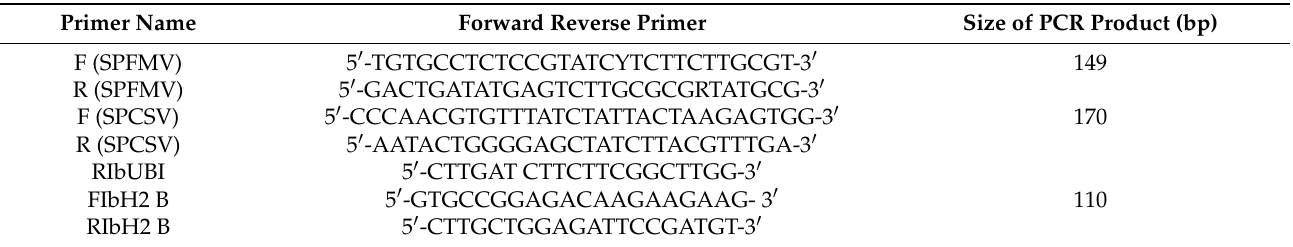
Table 4. Specific primers for RT-qPCR